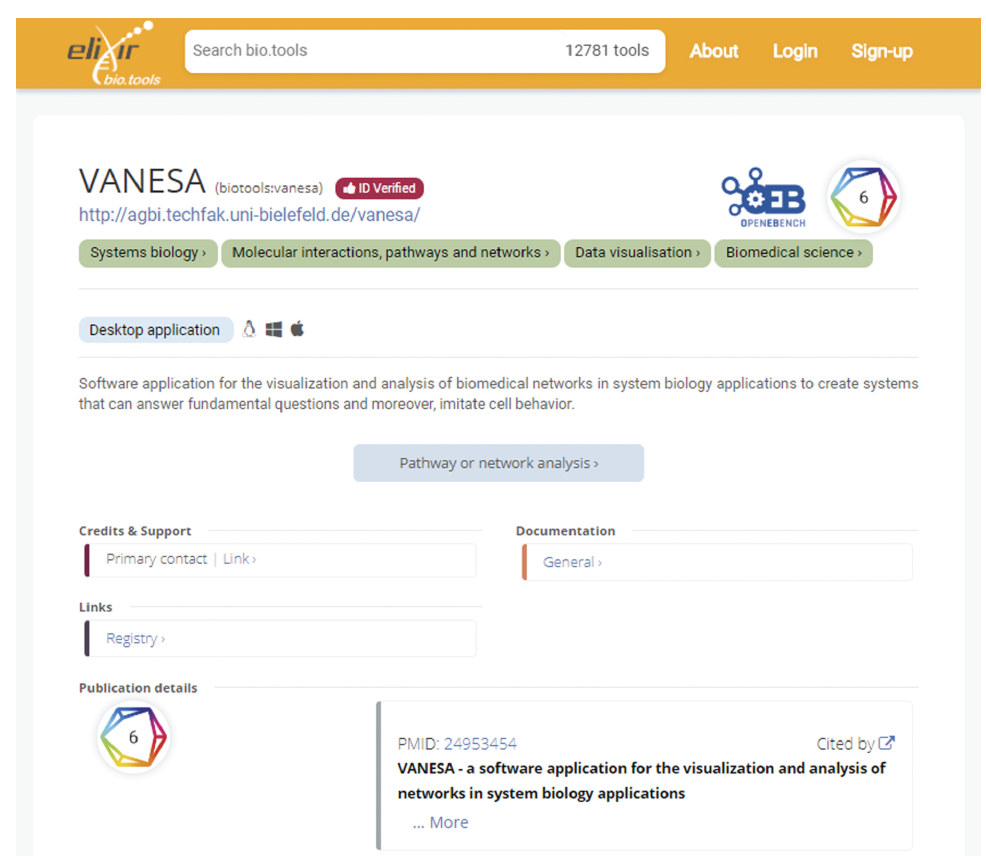
Figure 2: JIB.tools 2.0: details page for the “ VANESA ” tool published in JIB. It shows the use of tags synchronized from bio.tools, references of JIB publications, three screenshots, and other informa- tion.